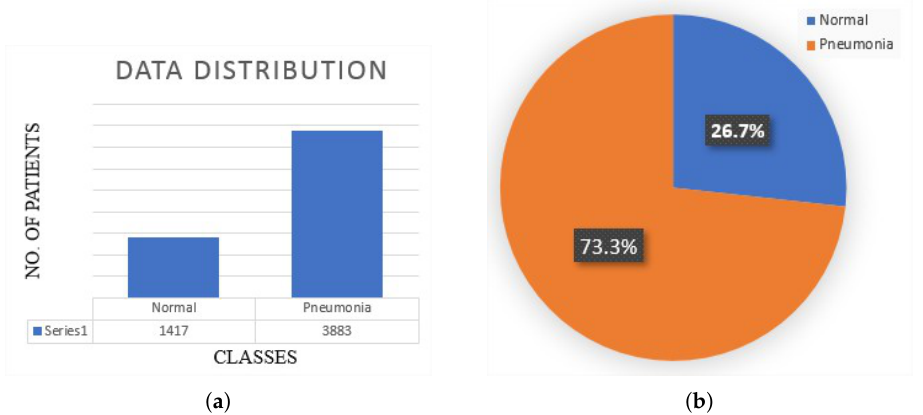
Figure 10. Distribution of dataset: ( a ) Population of normal and pneumonia patrinets in bar graph ( b ) Percentage of normal and pneumonia patients in pie